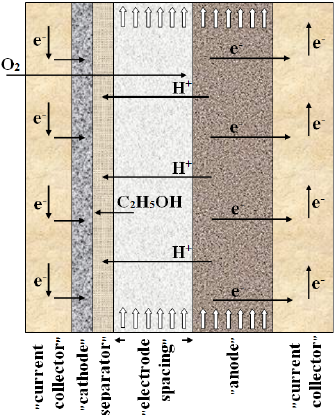
Figure 4. Schematic of charge transfer and reactants crossover paths in the passive air breathing FPMFC utilizing ethanol.